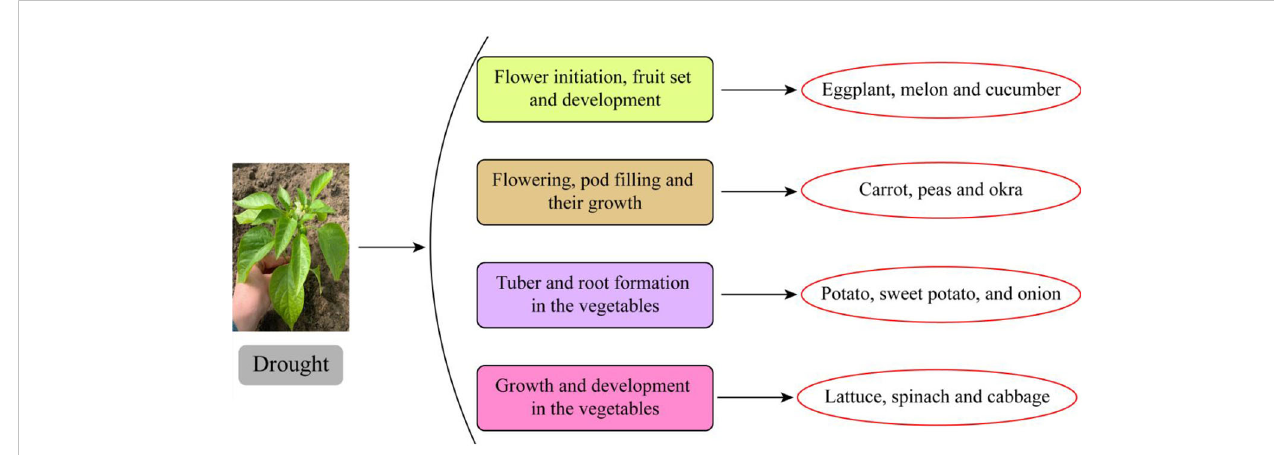
FIGURE 3 Impact of phytohormones on different vegetable crops growing under drought and salinity stresses.